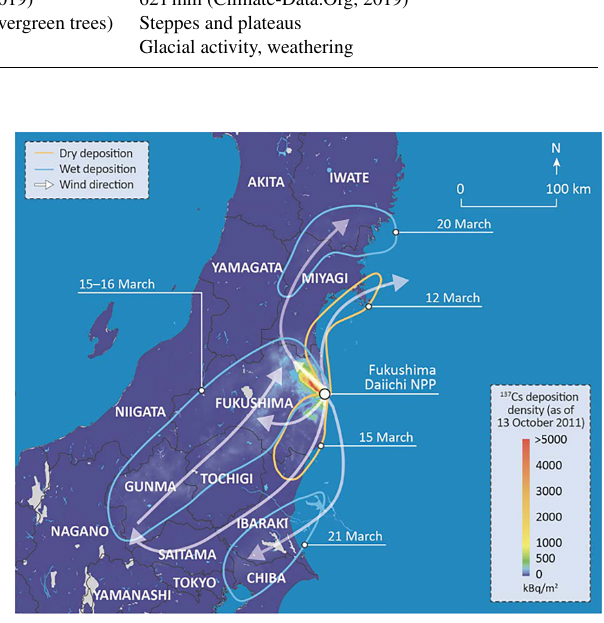
Figure 2. Timing and locations of the main Cs-137 deposition events following the explosions at the FDNPP (Map: IAEA,